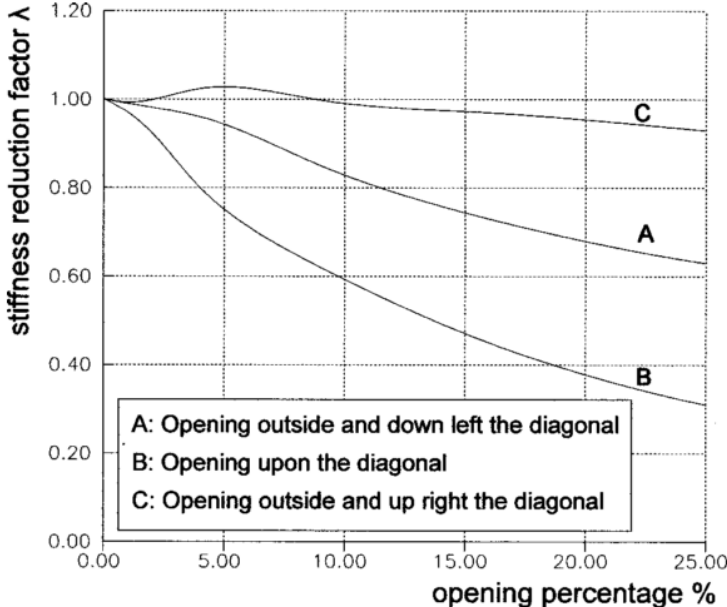
Figure 7. Stiffness reduction by number of openings on the infill wall (adapted from Ref. [262]). El-Dakhakhni et al. (2003), following the analytical and experimental work in (El- Dakhakhni 2000; El-Dakhakhni et al., 2001; El-Dakhakhni 2002), proposed a model with three diagonal struts (see Figure 8) in each direction, one in the diagonal of the panel and the other two non-parallel and off-diagonal [8,9,264,265]. According to the researchers their model was more successful in predicting the stiffness of the wall and describing the development of stresses along the frame elements compared to other models with fewer diagonal struts. The model was implemented in ANSYS software (ANSYS-Inc., Canonsburg, PA, USA, 2012) [266]. The frame was modelled with elastic elements with the non-linearities lumped on the frame joints with springs. This simplified non-linear model was capable of computing the frame-infill interaction and corner crushing failure mechanism. The width of the diagonal strut (distance between the struts connected to the frame) used the contact length proposed by Saneinejad and Hobbs (1995) as [258]: